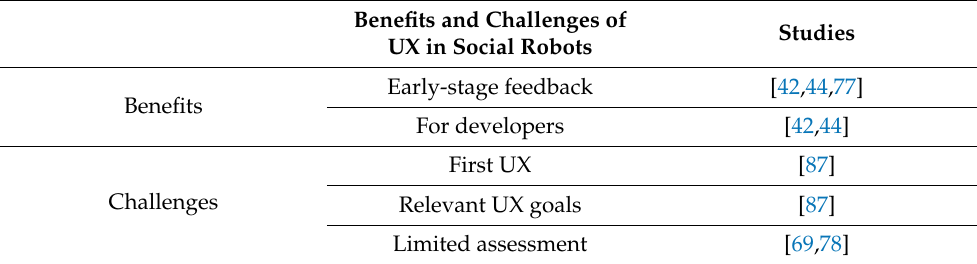
Table 4. Studies used to answer RQ 3